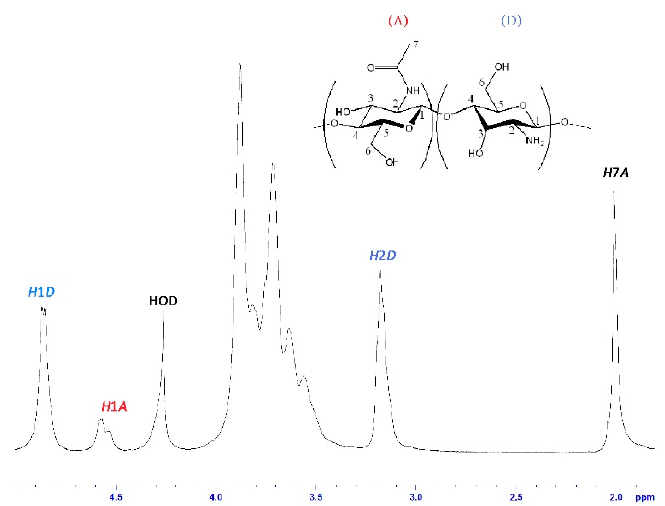
Figure 2. Proton nuclear magnetic resonance ( 1 H–NMR) spectrum of chitosan (CS) solution in DCl / D2O, at 70 °C (500 MHz).